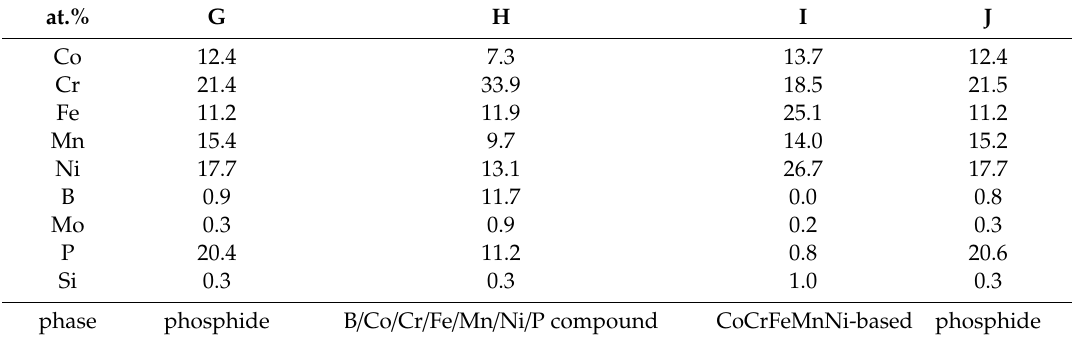
Figure 5. The BEIs of CoCrFeMnNi/MBF601/316 joints infrared brazed at ( a ) 1050 °C for 180 s, ( b ) 600 s and ( c ) 1080 °C for 600 s. Table 3. The EPMA quantitative chemical analyses in Figure 5.